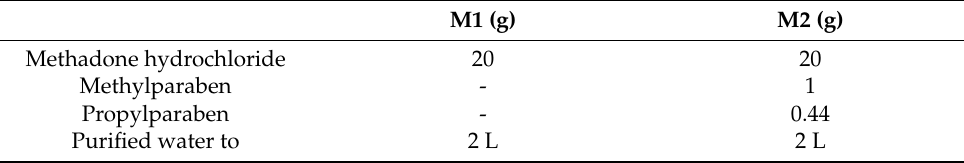
Table 1. Composition of methadone hydrochloride (10 mg/mL) oral solutions. M1 (g) M2 (g) Methadone hydrochloride 20 20 Methylparaben - 1 Propylparaben - 0.44 Purified water to 2 L 2